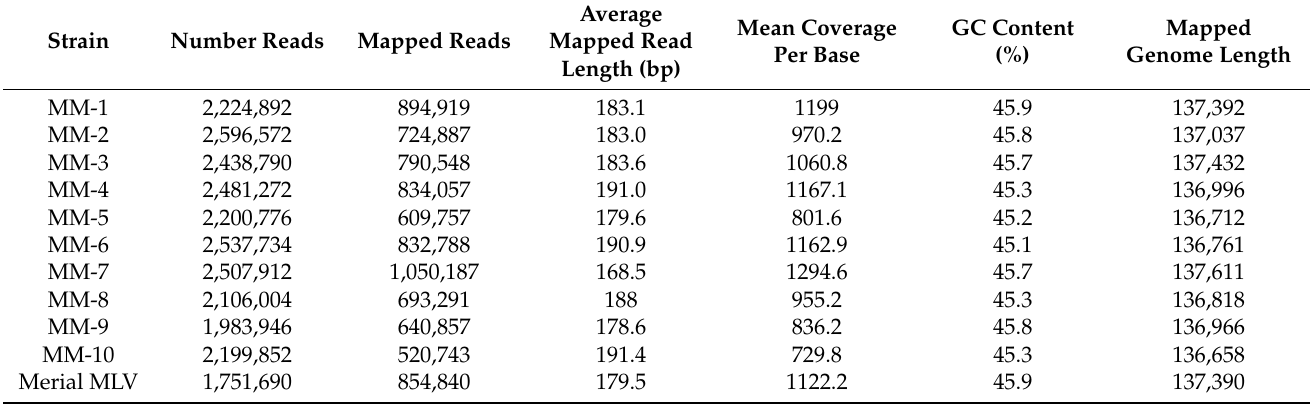
Table 2. Details of sequencing output for feline herpesvirus type 1 (FHV-1) strains isolated from 10 captive cheetahs (MM-1 through MM-10) and that in a modified live vaccine